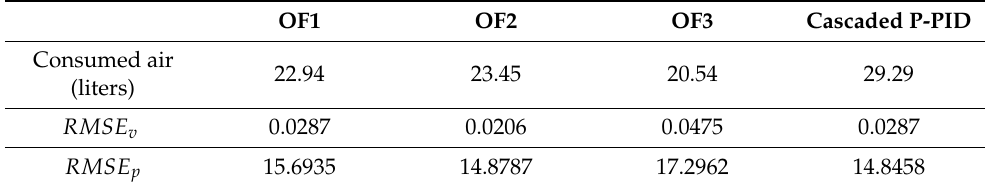
Table 4. Final air consumption values, root mean squared velocity and position error.